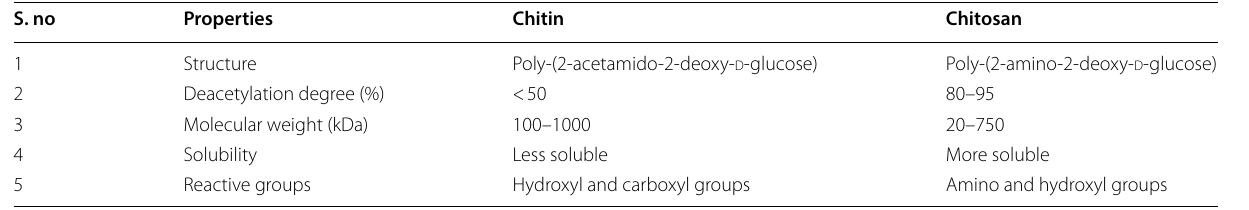
Table 4 Physiochemical properties of chitin and